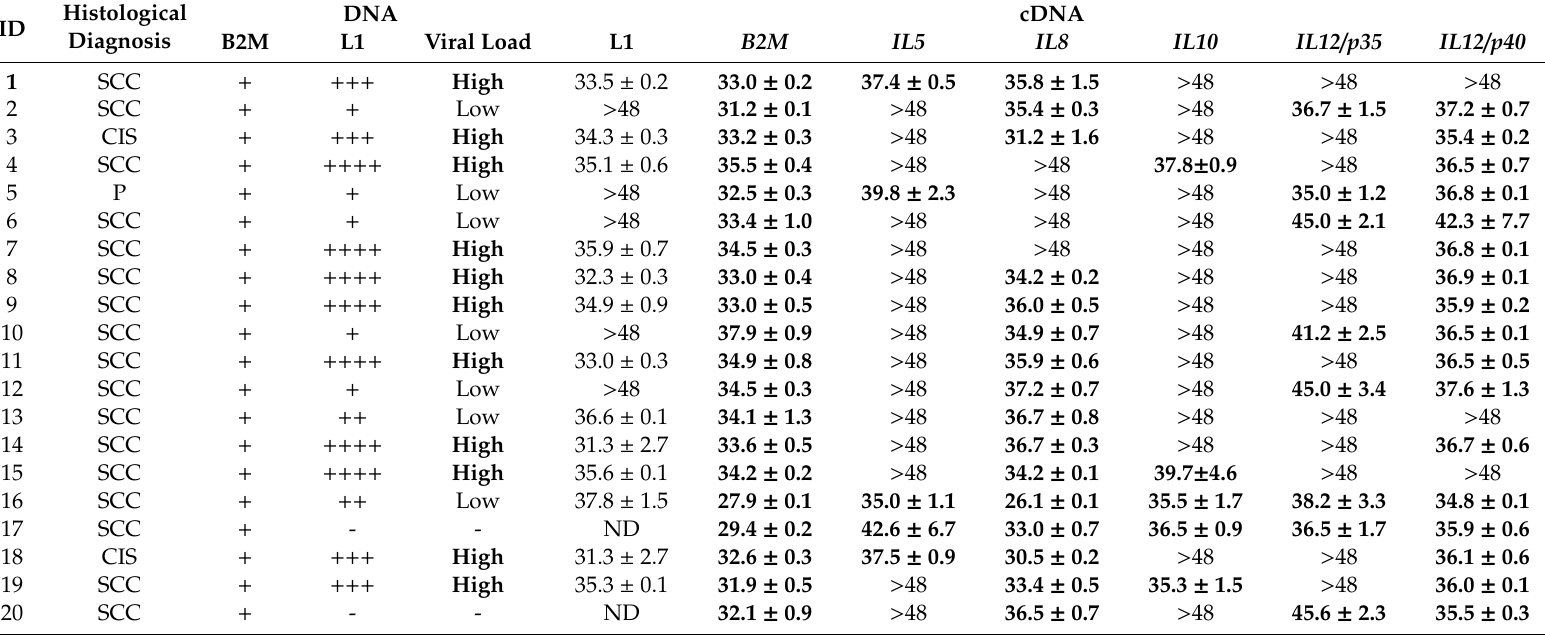
Table 6. Histological diagnosis: SCC: squamous cell carcinoma; CIS: carcinoma in situ; P: papilloma. RT-PCR data for B2M are expressed as + (amplified) or – (not amplified); Indication of the viral load was give indicating the Cq at which the positivity for L1 was detected: − ( > 48 Cq), + (32–37 Cq), ++ (26–31 Cq), +++ (20–25 Cq), and ++++ (14–19 Cq). All samples were classified into EcPV2 high when viral load was +++ or ++++ and into EcPV2 low when viral load was ++ or + . RT-qPCR data are expressed as mean Cq ± 1-standard deviation of three replicates. Negative sample are given > 48